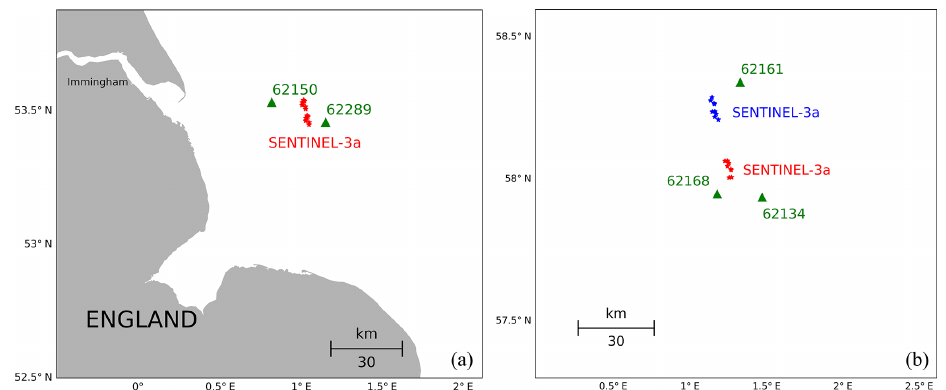
Figure 8. (a) Example of observation configuration with a descending Sentinel-3A altimeter track passing between two in situ wave ob- servation instruments (62150 and 62289), (b) Observation geometry with Sentinel-3A track passing through a group of three in situ wave measurement devices. The blue and red altimeter measurements are used to estimate error correlations for both the altimeter and the numerical